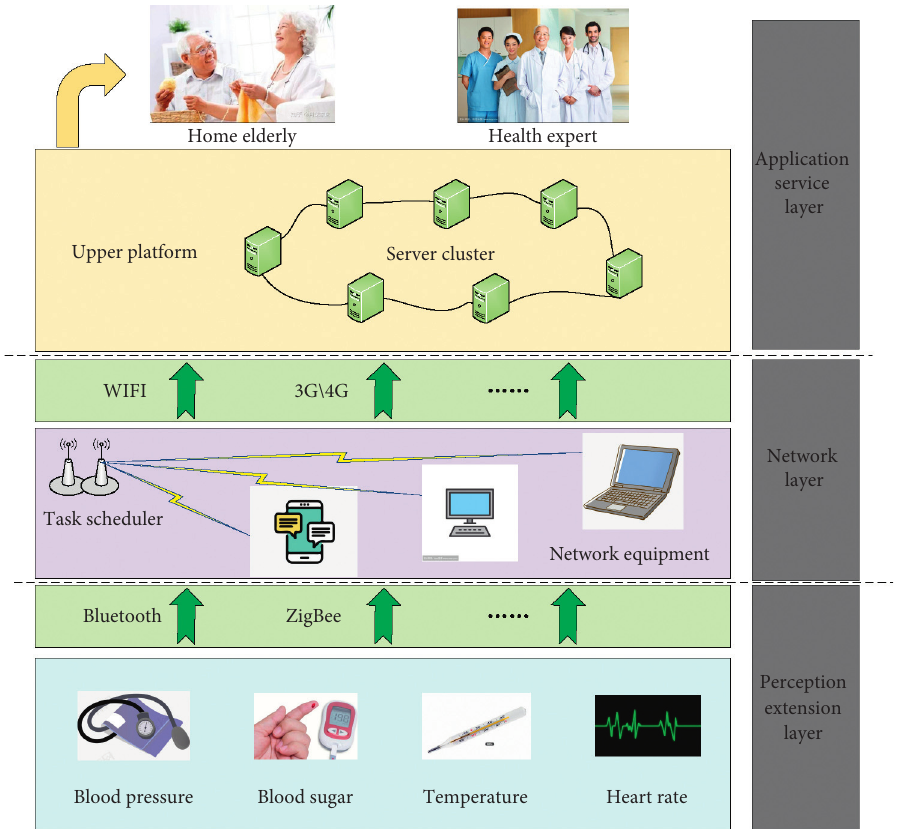
Figure 1: The overall architecture of the health information service